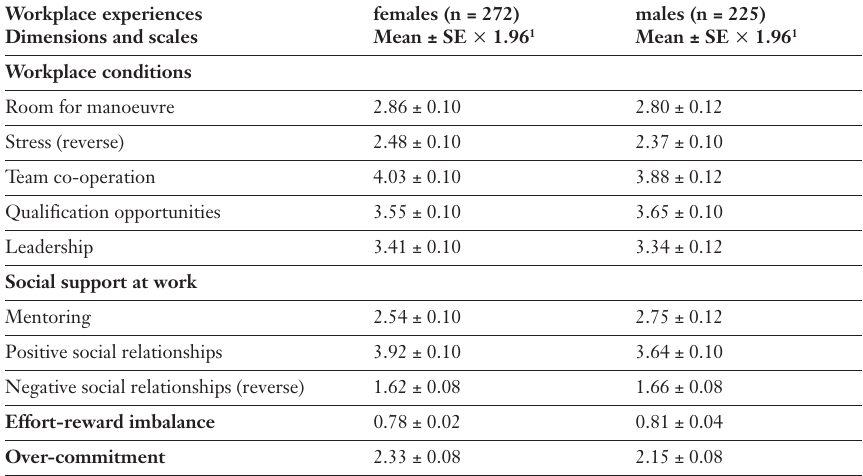
Multivariate analyses of covariance.